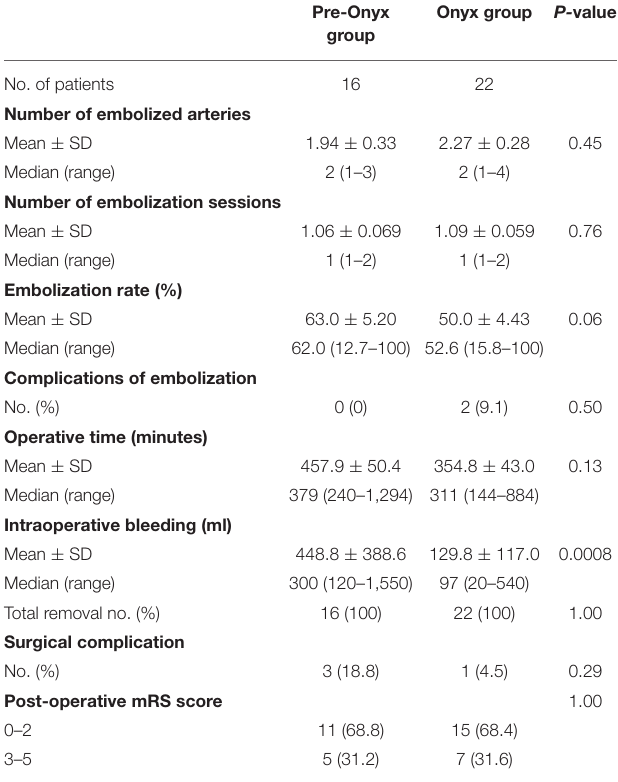
TABLE 4 | Treatment results.